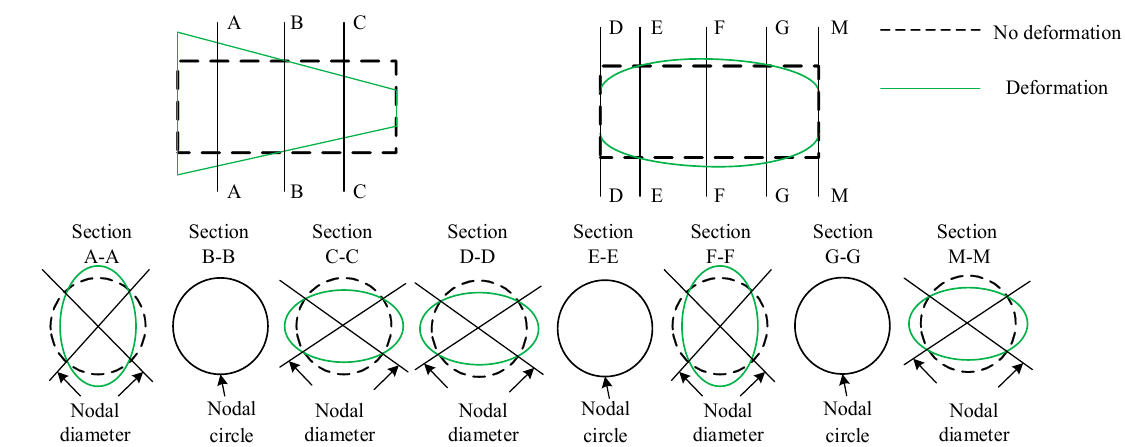
Figure 7. Vibration mode of ring gear.